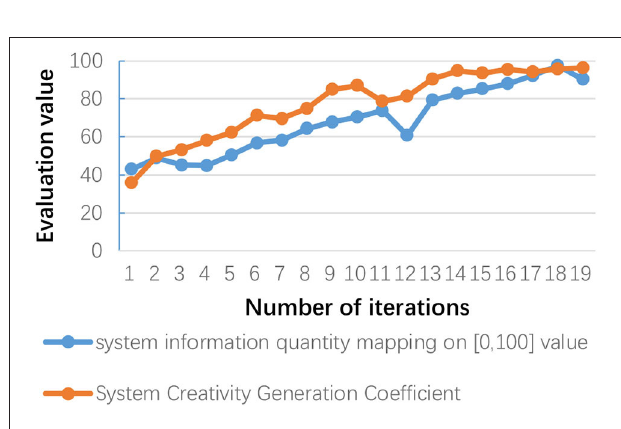
FIGURE 13 | Information volume and creative generation